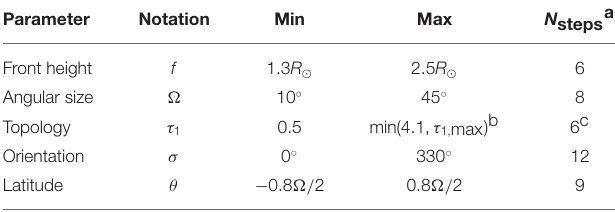
TABLE 1 | Ranges of the G&L